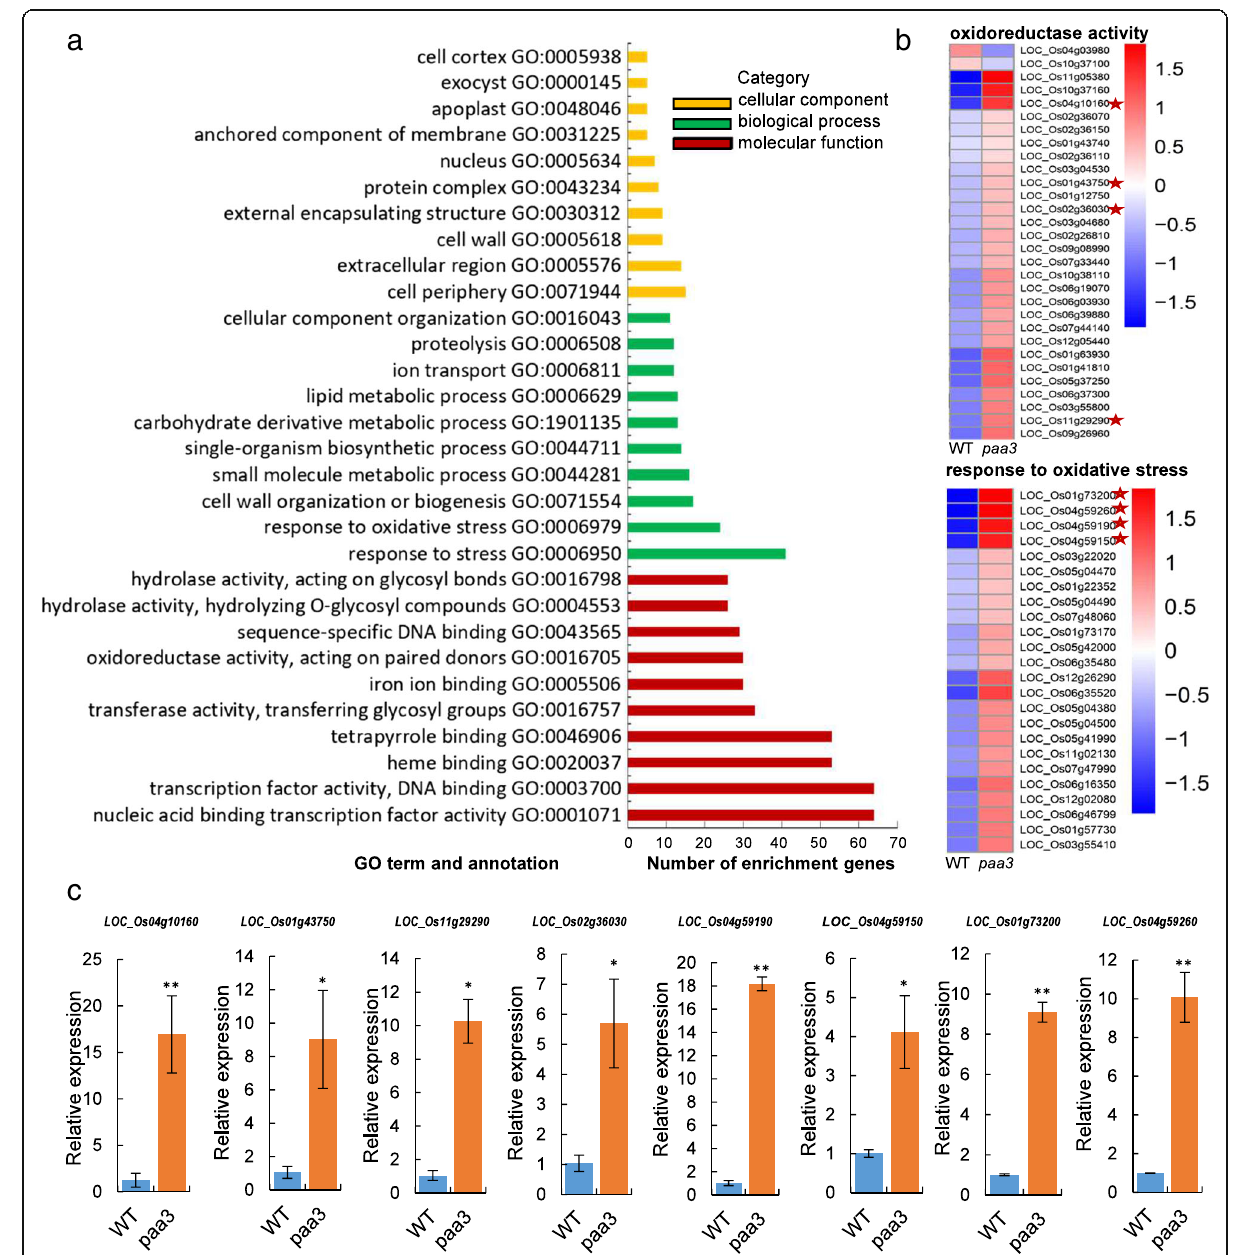
Fig. 7 Transcriptome analysis (GO enrichment term). a : Comparison of GO enrichment analysis. The top 10 significantly enriched GO terms for cellular component (CC), biological process (BP), and molecular function (MF) in paa3 mutant relative to normal panicle development in WT plants are shown in yellow, green, and red, respectively. b : Heat map based on FPKM values showing expression pattern of randomly selected genes involved in oxidoreductase activity (from FM) and response to oxidative stress (from BP). (Red and blue indicate the relative expression of one gene in WT and paa3 mutant, respectively. The darker the color, the greater the difference) The yellow star represents the gene that we have picked out for qPCR verification. (The results have been shown in Fig. c) c : qPCR analysis of several genes related to the GO terms “ oxidoreductase activity ” and “ response to oxidation. ” * p < 0.05; ** p < 0.01 (Student ’ s